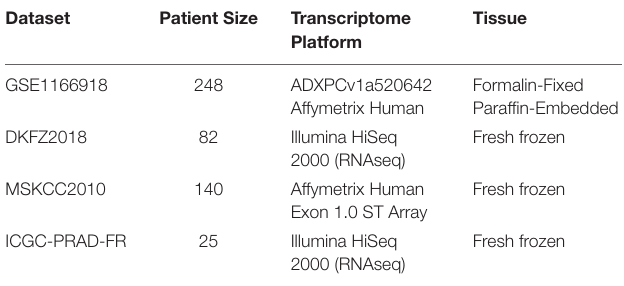
TABLE 2 | Information of the four publicly available independent validation